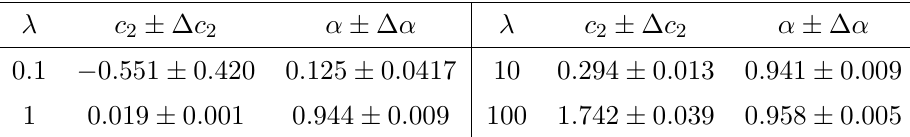
Table 1 . Parameters α and c 2 of the nonlinear regression analysis of the entanglement en- tropy (3.22) for non-Gaussian states to the nonlinear function (4.4). Different values of the coupling λ have been